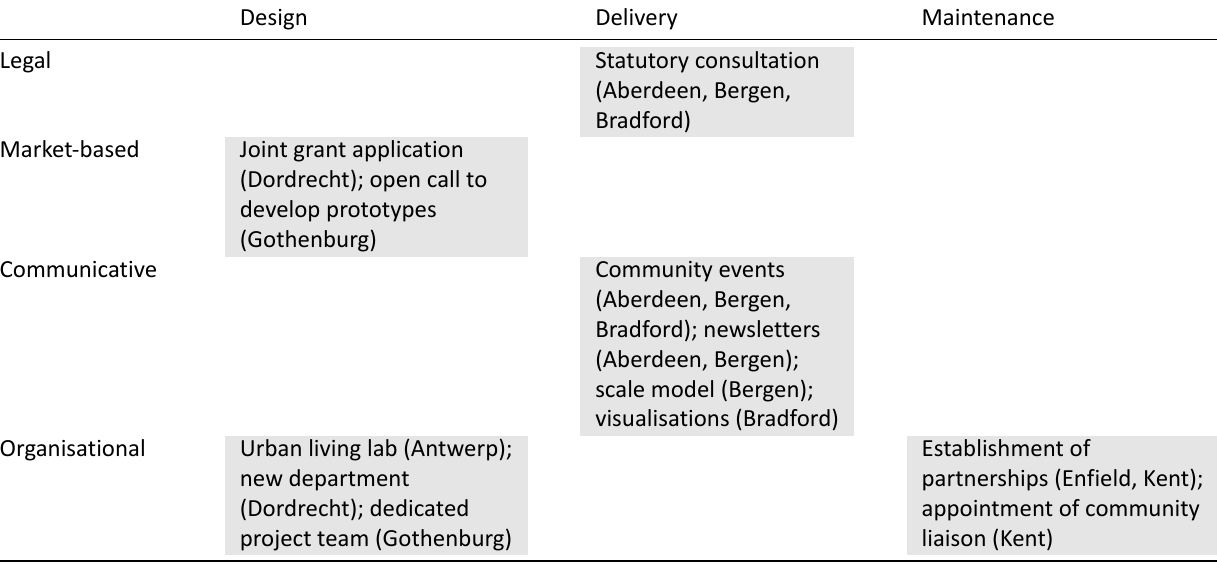
Table 2. The policy instruments used per phase and linked to the